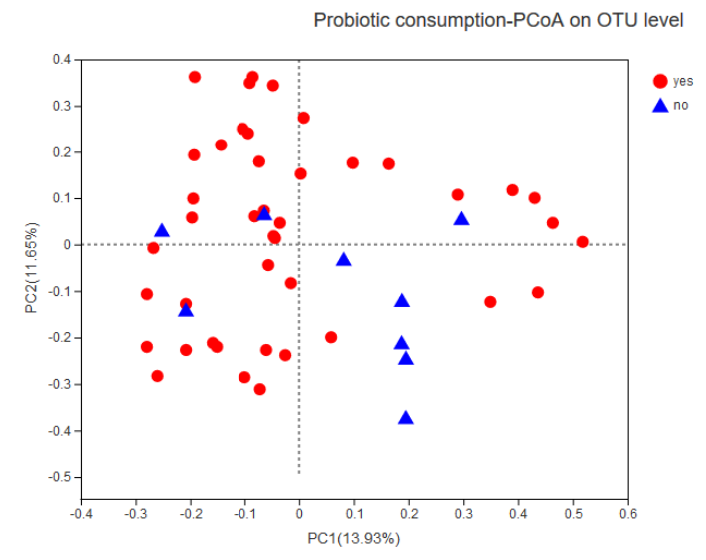
Figure 2. Principal coordinate analysis (PCoA) of infant gut microbiota using Bray–Curtis distance matrix. A two-dimensional PCoA was used to describe the relative abundance of infant gut microbiota based on sex, delivery mode, feeding type, and probiotic consumption. Each point represents a single sample and is color-coded into different groups.